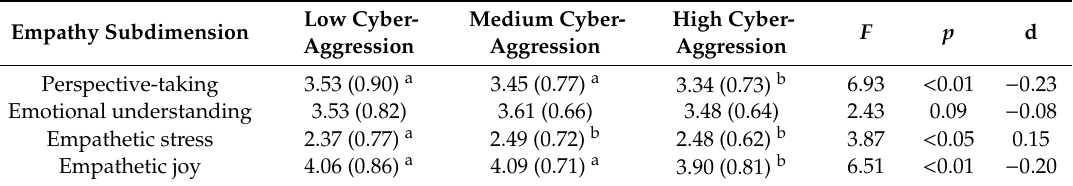
Table 3. Means, standard deviations (in parentheses), and results of the ANOVA of empathy for the groups of Low, Medium, and High